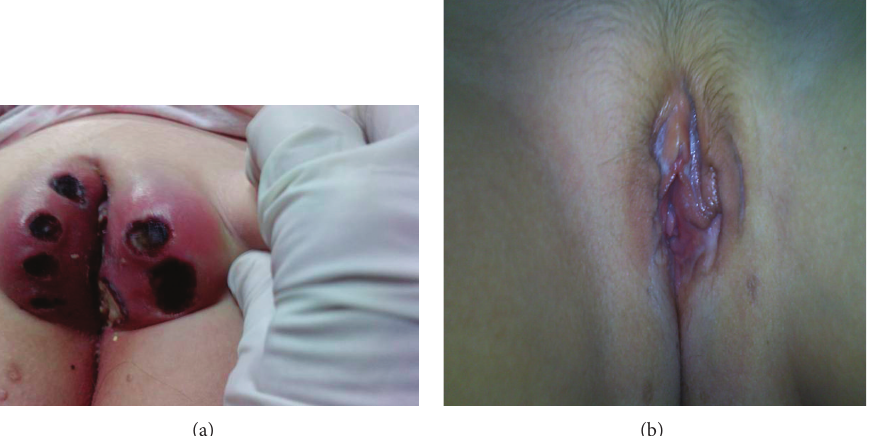
Figure 1: (a) Local necrotic lesions on the labia majora can be observed; the extensive oedema and erythema of the vulva, the black necrotic eschars,coveringtheulcersandthepurulentexudate.(b)Inaten-monthfollowup,thetissuedefecthaslargelybeenrestored.Theintervention of reconstructive surgery is a secondary